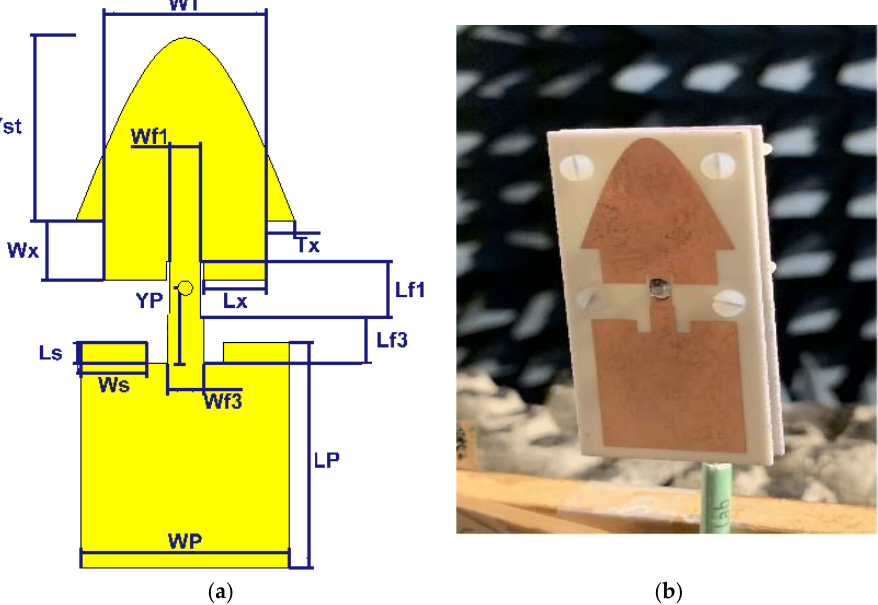
Figure 8. Configurations: ( a ) the 2 × 1 building block with an air layer ( b ) prototype of the 2 × 1 building block with an air layer.